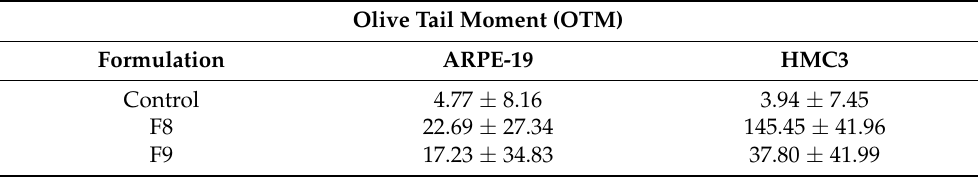
Table 7. Olive tail moments for formulations F8 and F9 in both cell lines, ARPE-19 and HMC3. Olive tail moment values describe the variations in DNA distribution within the comet tail. Values are presented as the mean ± standard deviation